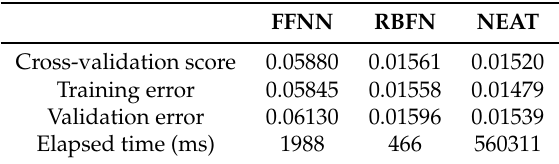
Table 4. Results of training by taking into account GHI and temperature and considering three different neural-network methods.